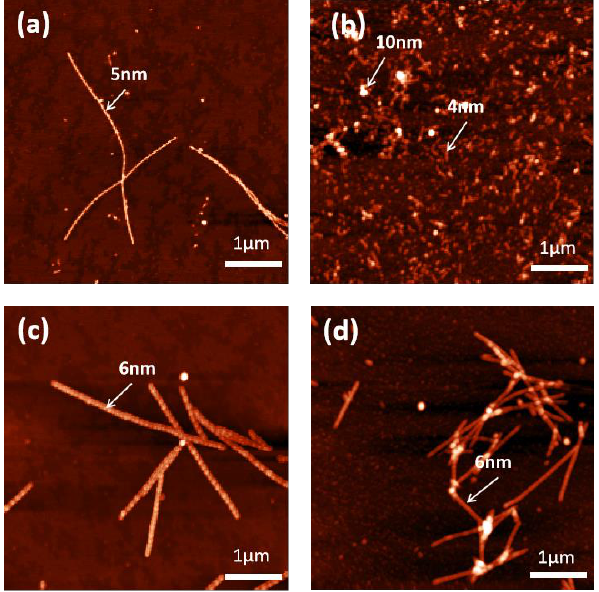
Figure 5. AFM results of the effects of Fe 3+ , Zn 2+ , and Cu 2+ on the morphology of α -synuclein amyloid fibril. ( a ) control; ( b ) 0.4 mM Fe 3+ ; ( c ) 0.4 mM Cu 2+ ; ( d ) 0.4 mM Zn 2+